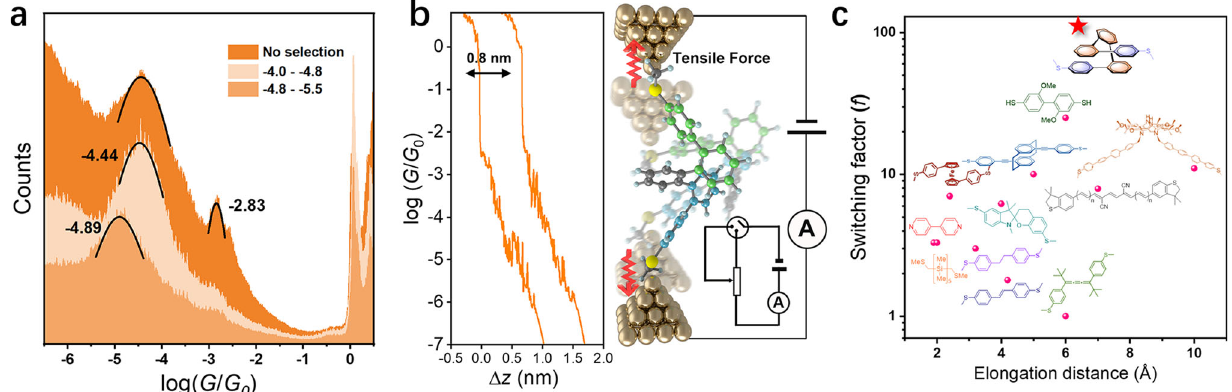
Fig. 5 Schematic illustration of o -PP derivatives as mechanical potentiometers based on STM-BJ measurement. a The one-dimensional histograms for o -PP-2SMe without data selection and with data selection among different conductance range in THF: TMB (1:4, v / v ), along with the values of the conductance peaks labeled beside the fi tting curves. b Typical “ downhill ” conductance – displacement traces for o -PP-2SMe and the schematic illustration of mechanical potentiometer based on o -PP-2SMe that can be elongated by tensile force then change the conductance. The inset is the circuit diagram containing the potentiometer. c The switching factor ( f ) versus elongation distance for the reported mechanically sensitive molecular wires.